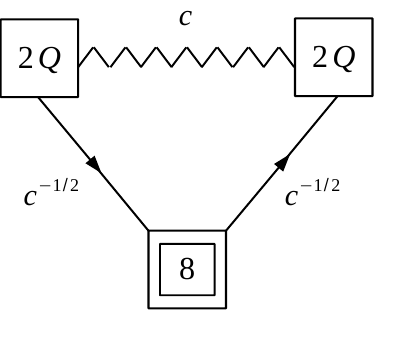
) . The squares denote , 1 , 1 , 1 , 1 , 1 , 1 , 1 2 2 2 2 2 2 2 2